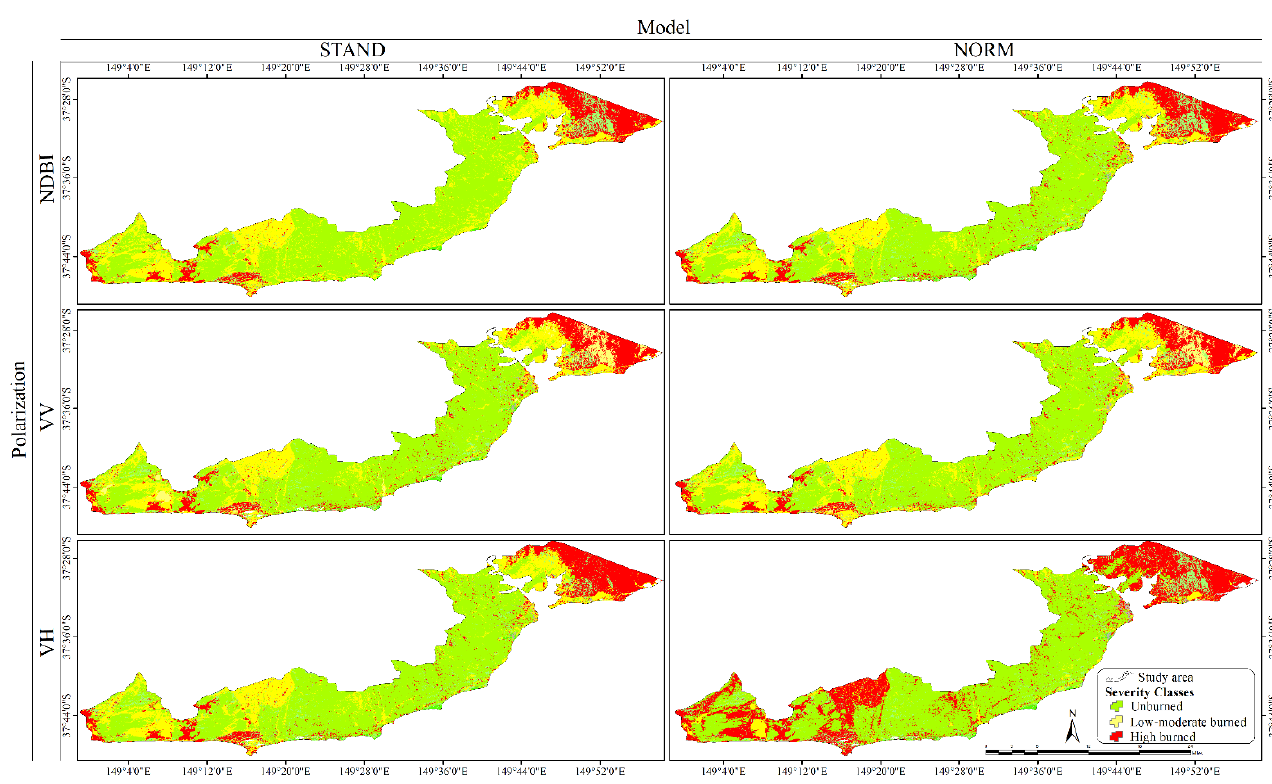
Figure A1. Dry condition.